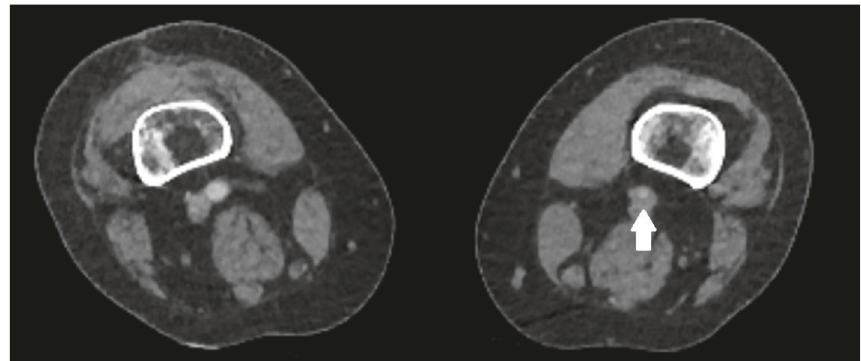
Figure 1: A CT angiogram demonstrates an occlusive thrombus (white arrow) of the left common femoral